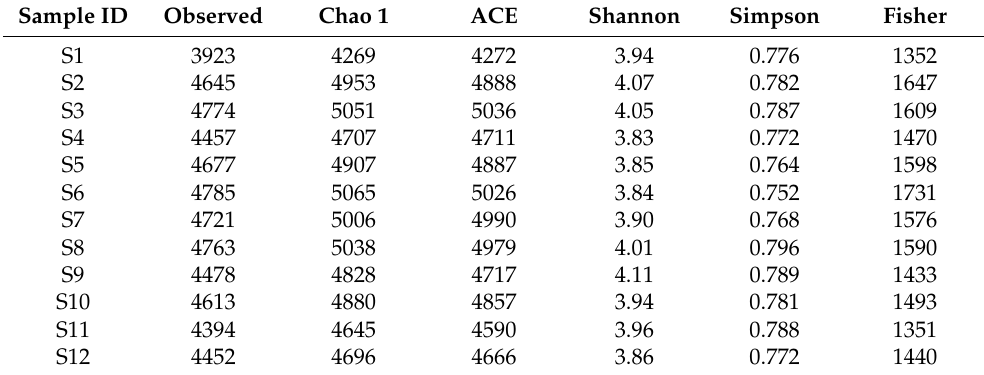
Table 1. Alpha diversity indices of microbial diversity in marine sediment